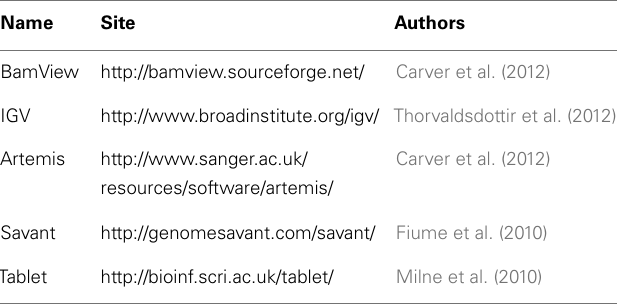
Table 9 |Tools for visualizations of HTS